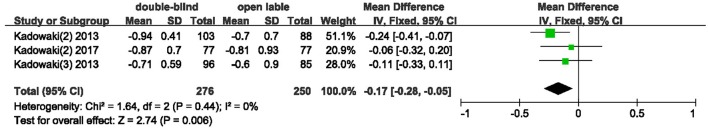
Comparative effect of teneligliptin in double-blind period vs. different follow-up time.